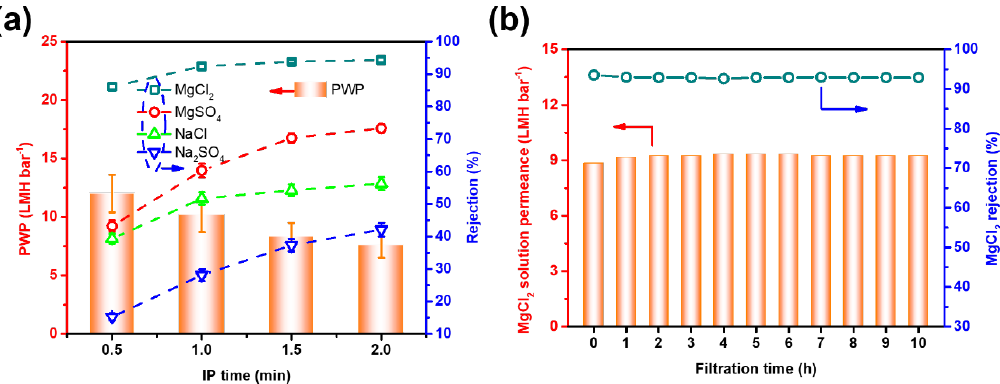
Figure 5. ( a ) The effect of IP time on NF performance of TAEA-PIP NF membranes, keeping the concentration of 0.01% PIP constant; ( b ) long-term stability of the prepared TAEA-PIP0.01 NF membrane, 1 g/L MgCl 2 . (4bar, 25 ± 3 °C).